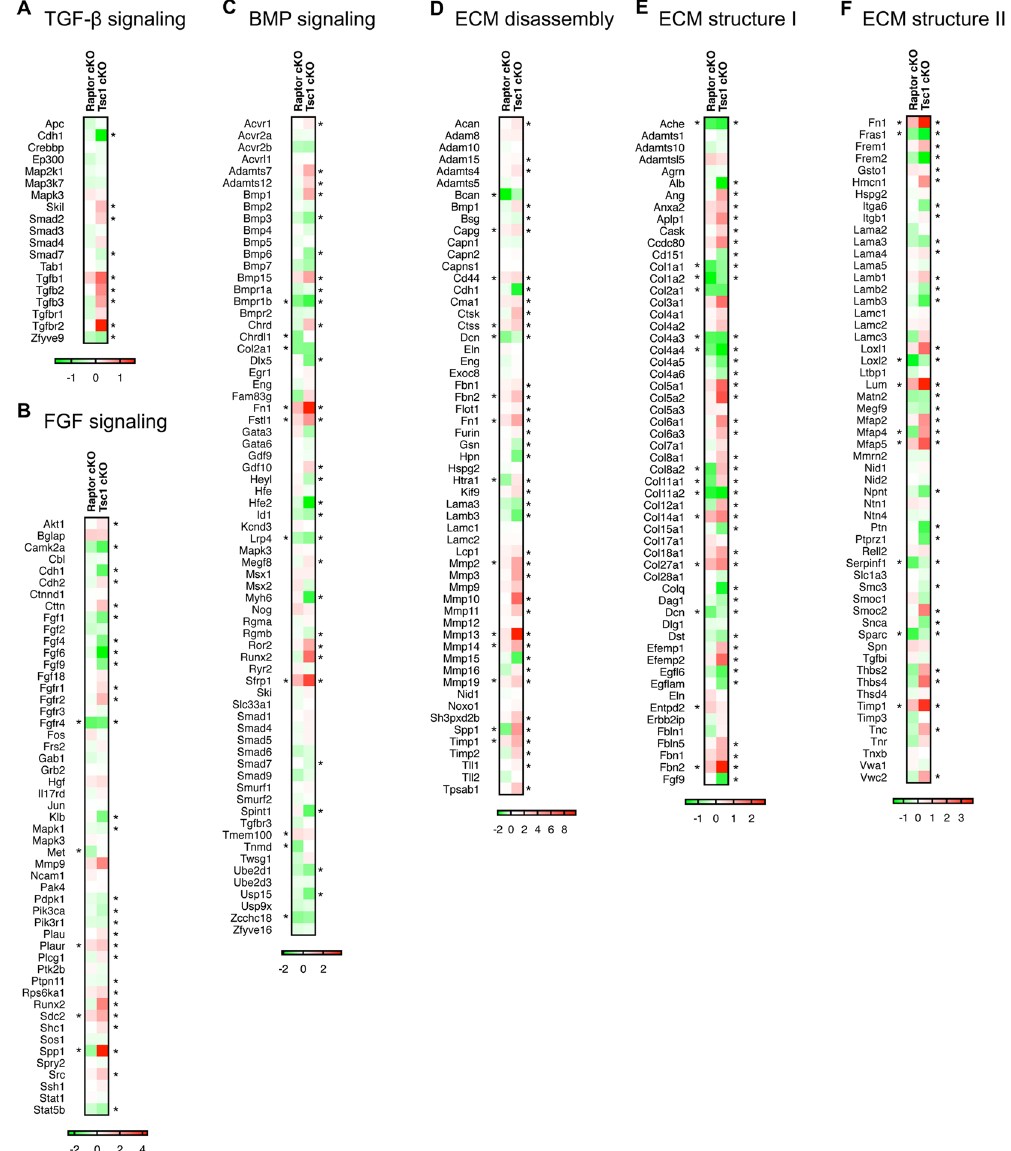
Figure 6. Transcriptome analysis of tendons from loss- and gain-of-function mouse models of mTORC1. The Gene Set Enrichment Analysis (GSEA) database was used to identify and plot Log2 fold change in RNA-seq data from Achilles tendons of Raptor conditional knockout (cKO) mice (control vs. Scx-Cre; Raptor f/f ) or Tsc1 cKO (control vs. Scx-Cre; Tsc1 f/f ) mice in ( A ) TGF- β signaling, ( B ) FGF signaling, ( C ) BMP signaling, ( D ) extracellular matrix disassembly, and ( E , F ) extracellular matrix structure (n = 3, * p <